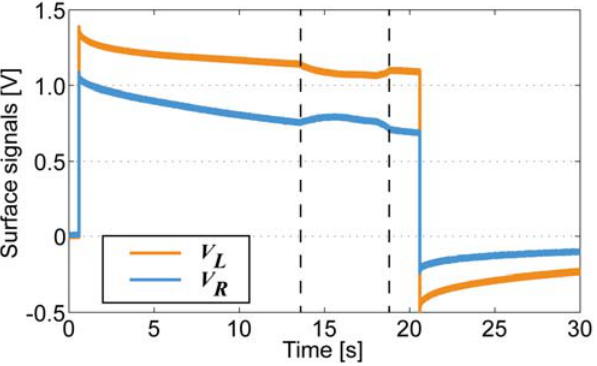
Figure 17. Voltage drops along the surface of the CPC actuator, free movement of the actuator was obstructed at the 14th second of the